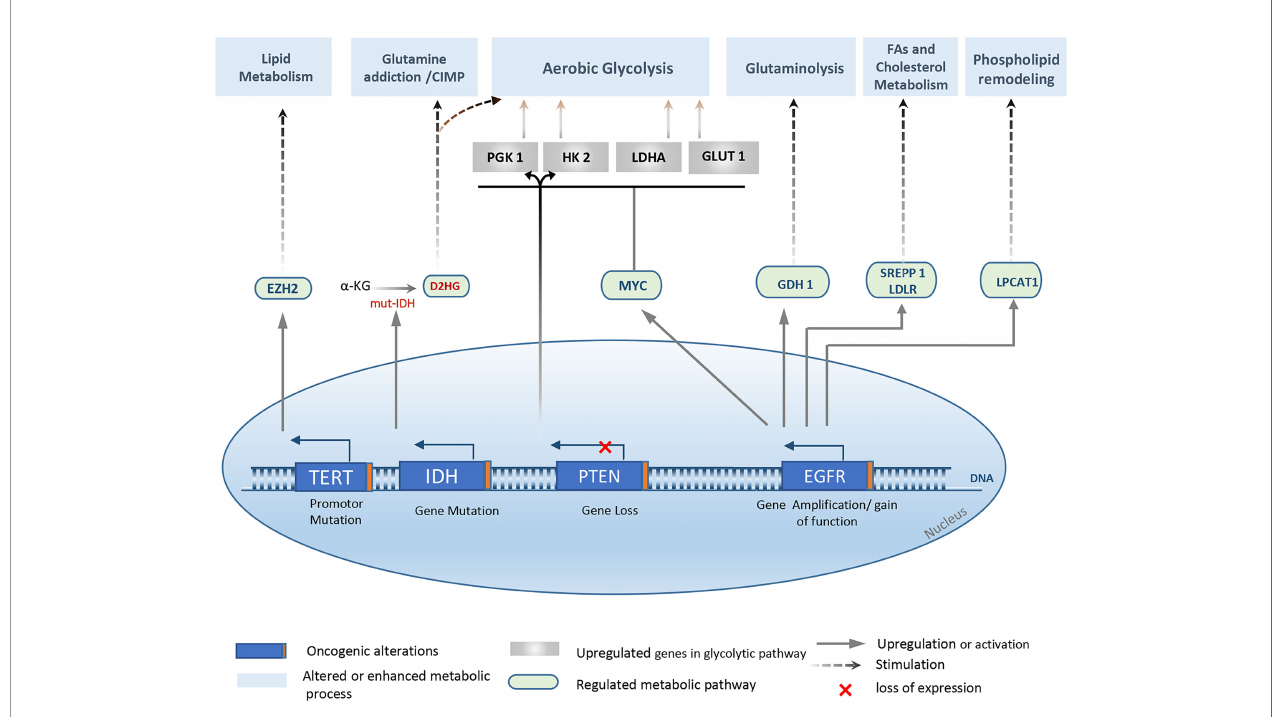
FIGURE 2 | Overview of the major genetic alterations that drive metabolic reprogramming in Gliomas. Metabolic changes observed in gliomas and especially in glioblastoma are associated with several genetic abnormalities, mainly, IDH ½ mutation , EGFR ampli fi cation, mutation, or EGFRvIII activation. Also, PTEN loss, and TERT promoter mutation. Various metabolic pathways are affected, yielding a new metabolic pro fi le that supports the high proliferative characteristic, cell adaption, and tumor progression. EZH2, Enhancer of zeste homolog 2; D2HG, d-2-hydroxyglutarate; SREPP 1, sterol regulatory element-binding protein 1; LPCAT1, lysophosphatidylcholine acyltransferase 1; LDLR, glutamate dehydrogenase 1; LDHA, Lactate dehydrogenase A; GDH 1, glutamate dehydrogenase 1; PGK 1, phosphoglycerate kinase